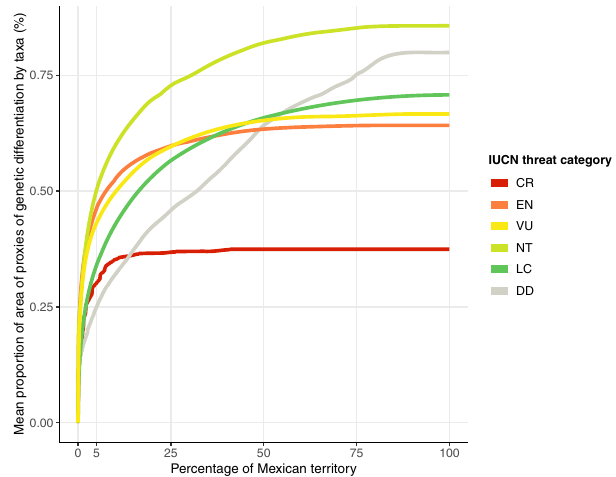
Fig. 6 | Performance curves quantifying the representation of proxies of geneticdifferentiationwithinthedistributionofcropwildrelativesinMexico, based onthe hierarchical landscape priorityrank map (Fig. 5a)which is based on the “ SDM*PGD ” scenario, considering potential distribution models sub- divided by proxies of genetic differentiation (see Fig. 4), and including occurrence records for taxa without SDM, IUCN threat categories, as well as speci fi c habitat preferences (see text for details). The information on habitat of CWR included in the analysis revealed that a substantial amount of habitat had already been converted to other land uses, thus it was no longer possible to completely represent taxa distribution ranges and the associated intra-speci fi c variation. Data is grouped by IUCN Red List Category of taxa (CR critically endan- gered, EN endangered, VU vulnerable, NT near threatened, LC least concern, DD data de fi cient). Performance was evaluated for 116 taxa with potential species distribution model. Source data is provided as a Source Data fi